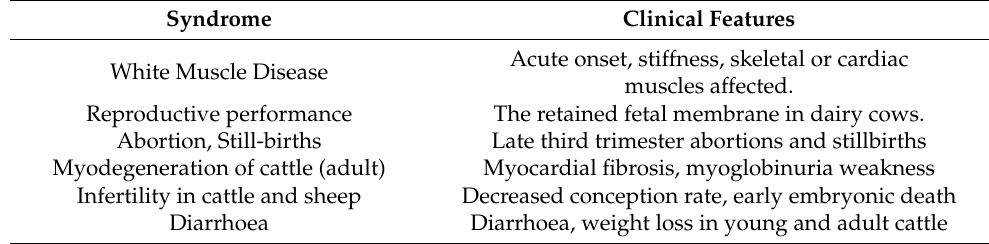
Table 1. Se responsive diseases in animals. Syndrome Clinical Features Acute onset, stiffness, skeletal or cardiac White Muscle Disease muscles affected. Reproductive performance The retained fetal membrane in dairy cows. Abortion, Still-births Late third trimester abortions and stillbirths Myodegeneration of cattle (adult) Myocardial fibrosis, myoglobinuria weakness Infertility in cattle and sheep Decreased conception rate, early embryonic death Diarrhoea Diarrhoea, weight loss in young and adult